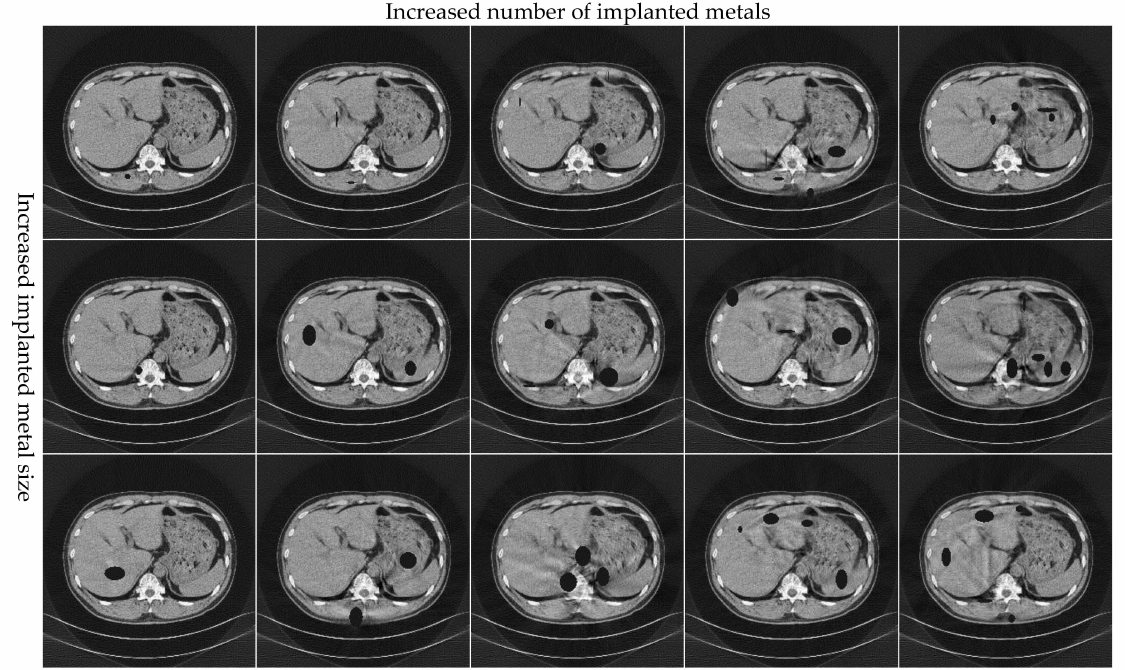
Figure 7. Simulation results of the pleural with different numbers, shapes, and sizes of metal implants. The display window of CT is ( − 0.1, 0.25).